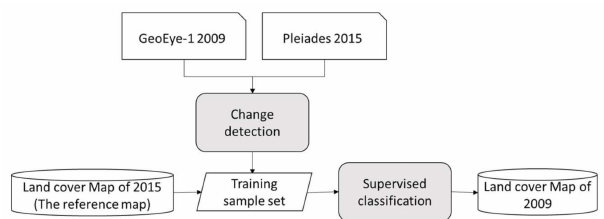
Figure 5. Flowchart of land cover classification using transfer learning.